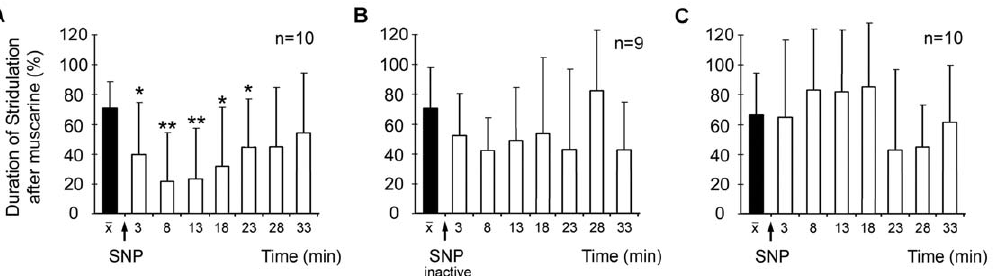
Figure 7. Pharmacological stimulation of sound production by pressure injection of neuroactive substances into the central complex of restrained male Ch.biguttulus . A: The duration of stridulation stimulated by 10 2 4 M muscarine (black column) was reversibly reduced by a single injection of the NO donor SNP (10 2 3 M) to the same site in the central complex. Significant differences (**: p # 0.01; *: p # 0.05) were calculated with respect to the muscarine pulses before SNP application. B: After overnight storage in an unsealed vessel, SNP solution loses its potency to generate NO upon injection into the central complex. Inactivated SNP had no inhibitory effect on muscarine-stimulated stridulation. C: The duration of stridulation stimulated by 10 2 3 M picrotoxin was unaffected by co-application of SNP (10 2 3 M) to the same site in the central complex.